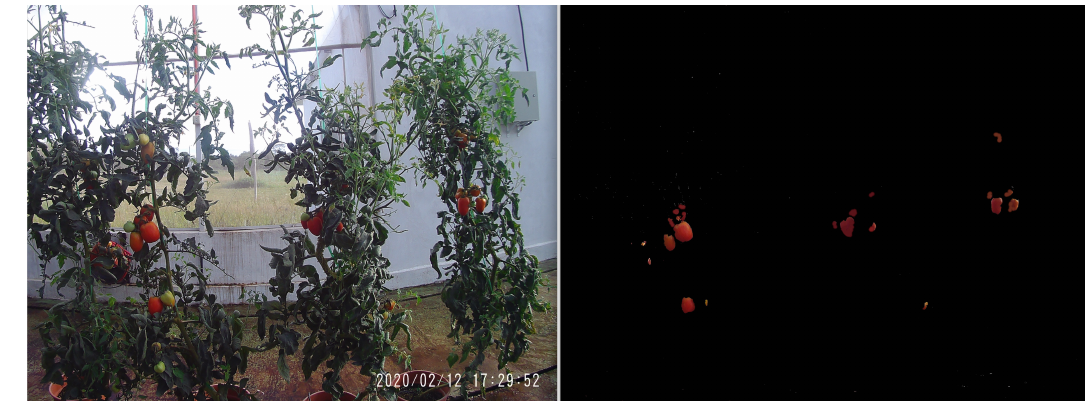
Figure 18. Photographic sample of the first sub plot with 50% of commercial nutritional solution and its digital PI processing with the date and time of the